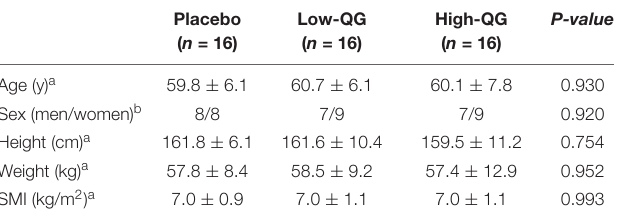
TABLE 1 | Participants’ baseline